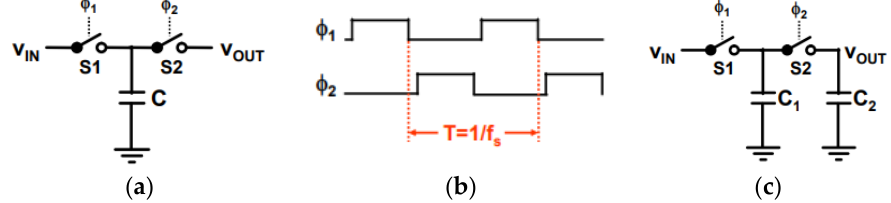
Figure 12. ( a ) Switched capacitor resistor; ( b ) non-overlapping clock; ( c ) low-pass filter.